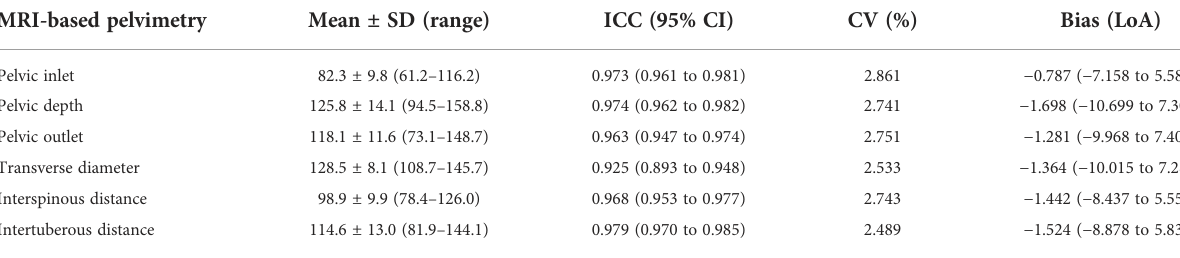
TABLE 3 The consistency of MRI-based pelvimetry between two